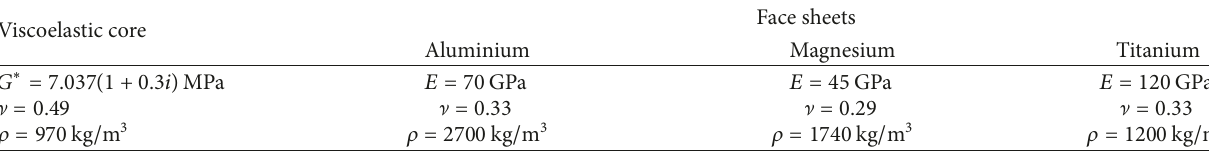
Table 7: Material properties for sandwich layers.